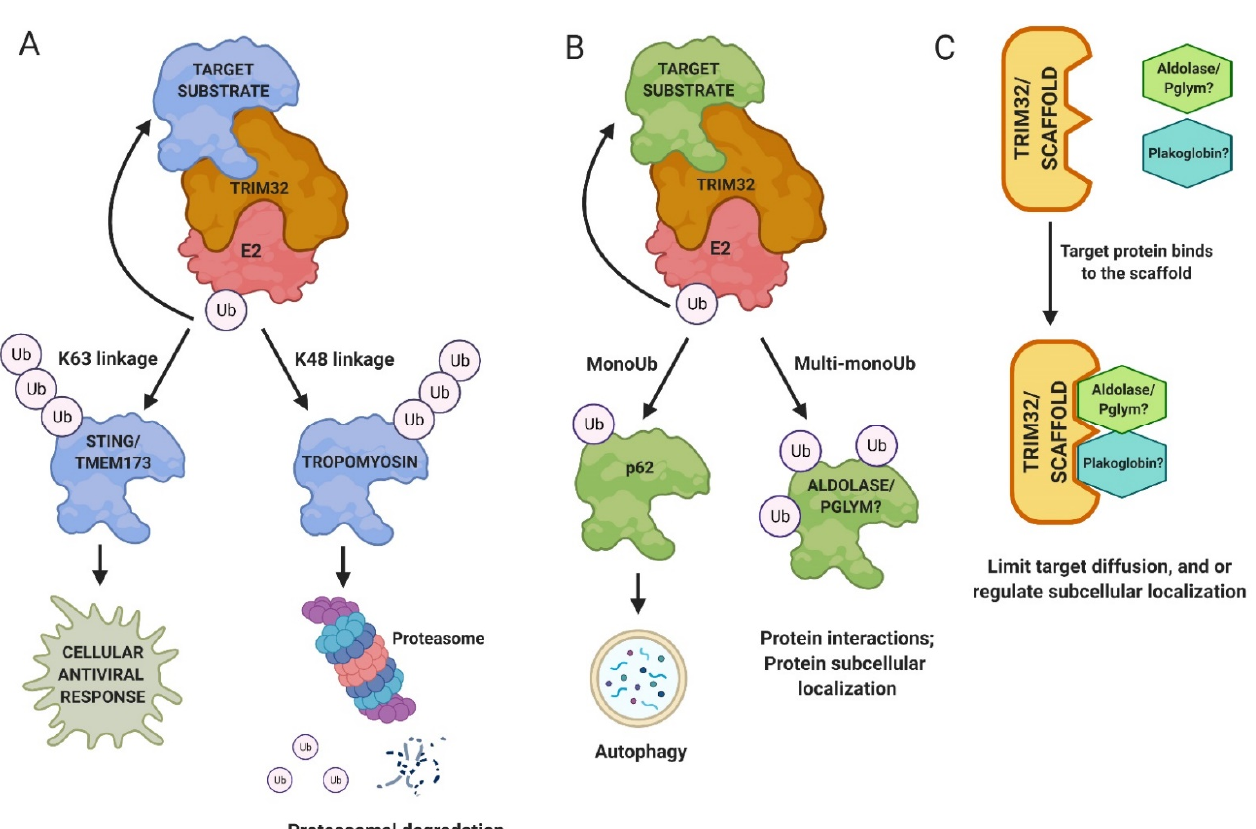
Figure 3. Mechanisms of TRIM32 function. ( A ) Polyubiquitination and proteasomal turnover of target substrates is a well-characterized role of TRIM32. ( B ) TRIM32 also appends single ubiquitin (Ub) molecules to proteins, resulting in either monoubiquitination or postulated multi-monoubiquitination. ( C ) Alternatively, TRIM32 may act as a scaffold protein to mediate protein localization within cells or to limit diffusion of proteins away for their sites of action.